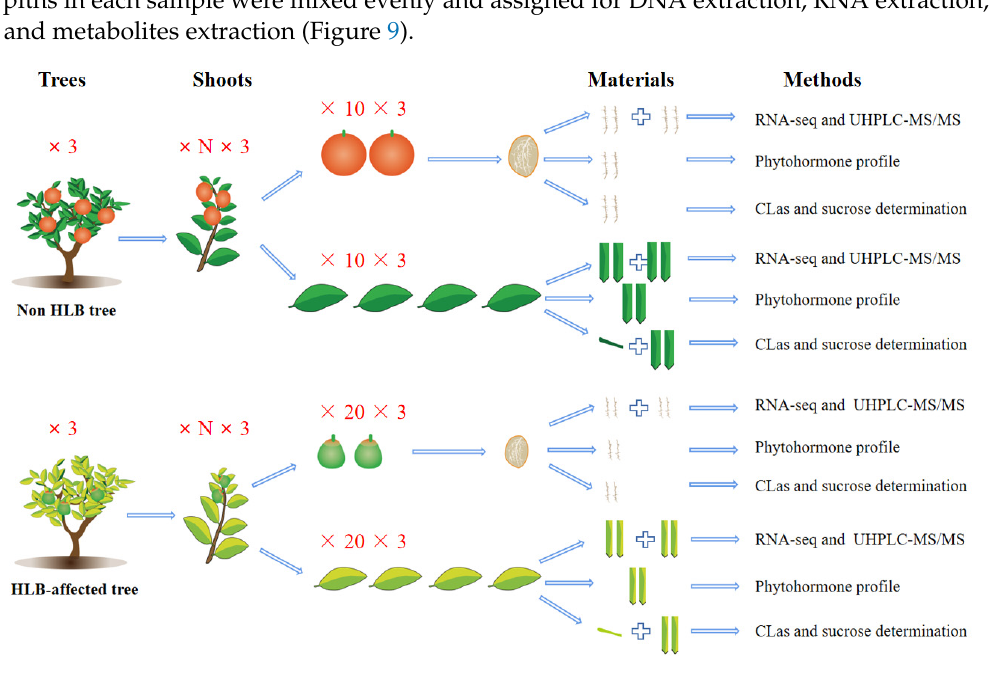
Figure 9. Diagram of the main materials and methods in this